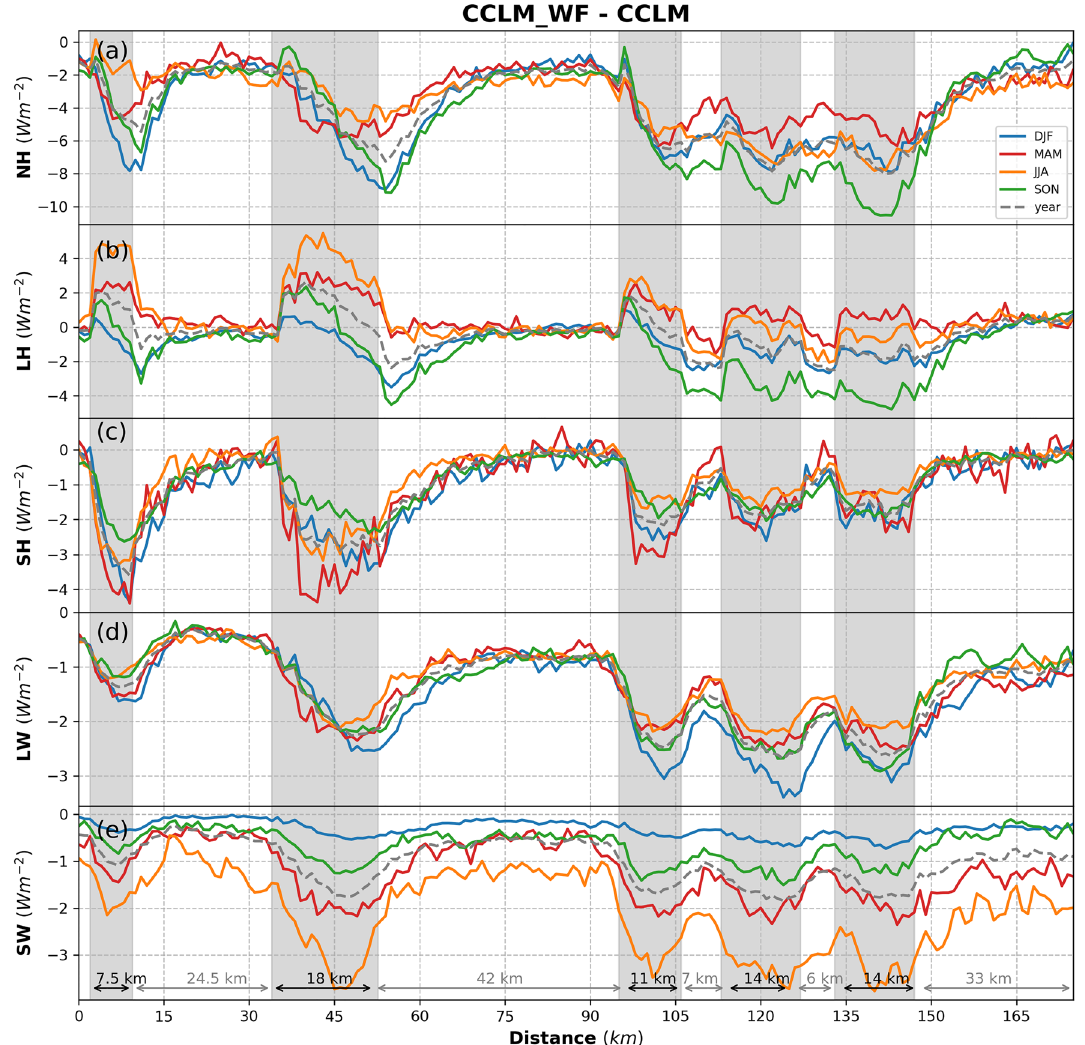
Figure 8. Transects of the seasonal (colored, see legend) and yearly deviation from means (dashed gray) for ( a ) 10-m wind speed, ( b ) turbulent kinetic energy, ( c ) 2-m specific humidity, ( d ) 2-m temperature, ( e ) low cloud amount, and ( f ) total precipitation for the prevailing wind directions of 200–280° in 2008–2017 taken at transect 1 (Dogger Bank, Fig. 1) latitude 54.4°N–55.8°N and longitude 0.8°E–3.15°E. Gray sectors indicate the wind farm